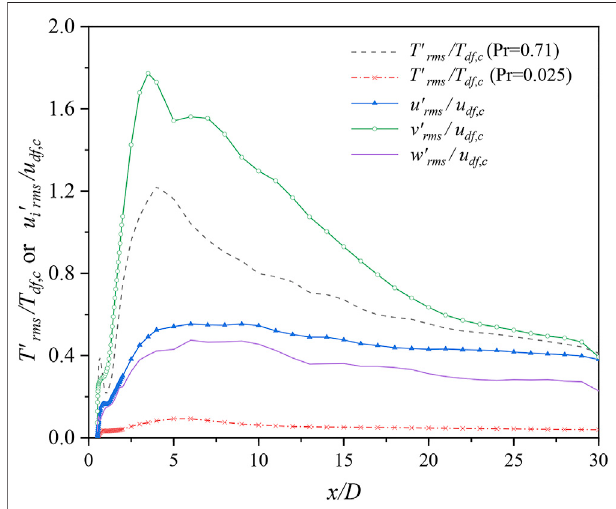
FIGURE 12 | Distribution of T ′ rms /T df, c , u ′ rms /u df, c , v ′ rms /u df, c and w ′ rms / u df, c on wake